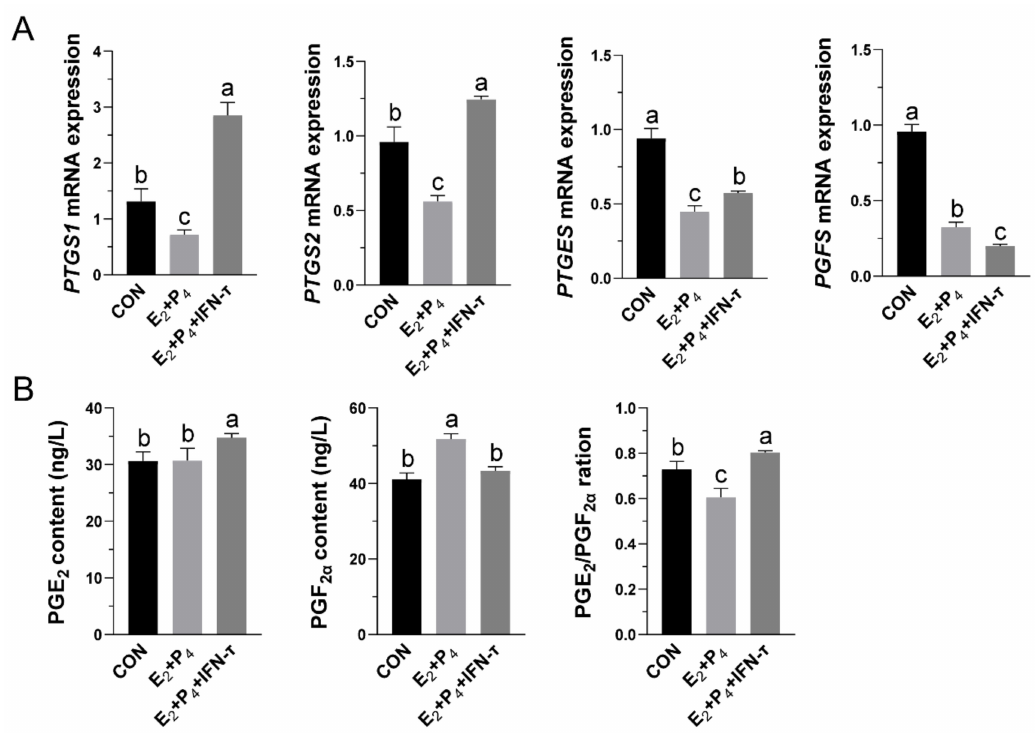
Figure 3. Effects of hormones on the secretion of PGs in STCs: ( A ) After 12 h of hormone treatment, the relative mRNA level of prostaglandin synthase was determined by real-time fluorescent quantitative PCR. The β -actin gene was used for normalization in all samples. ( B ) Secreted PGE 2 and PGF 2 α were measured by ELISA after 12 h of hormone treatment, and the ratio of PGE 2 /PGF 2 α was calculated. Data are shown as the mean ± standard deviation (SD) of three independent trials. In the CON group, 0.1% DMSO was added. Different letters above the bars indicate significant differences ( p <